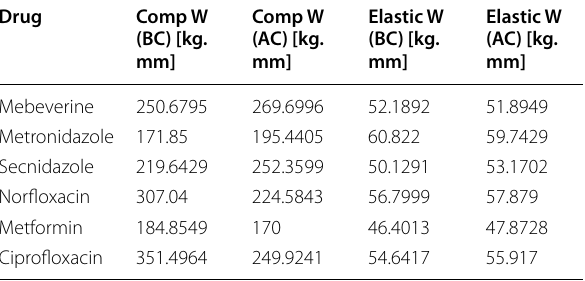
Table 2 Compression work and elastic recoveries calculated from the F-D curves of non-compacted (BC) and compacted (AC) drug powders at a GTP compression force of 500 kg (equivalent to a compression pressure of 173.3